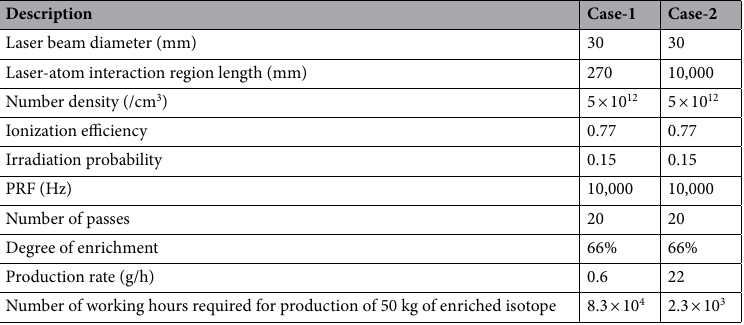
Table 4. A table of the production rates of enriched 150 Nd isotope for various experimental configurations of the AVLIS systems for different laser-atom interaction lengths. Angular divergence of the atomic beam is 30°. Bandwidths of all the excitation lasers are 100